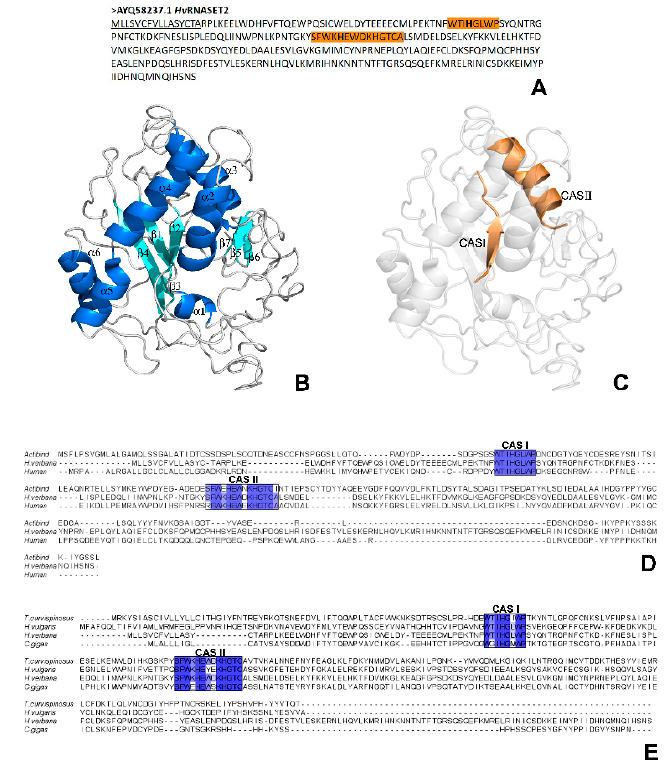
Figure 1. Hv RNASET2 bioinformatic characterization. ( A ) Hv RNASET2 (accession number: AYQ58237.1) amino acid sequence. In the N-terminal region, the underlined residues identify the signal peptide, and the two conserved active sites (CAS) are underscored in bright orange. ( B , C ) Secondary HvRNASET2 three-dimensional structure, predicted with I-TASSER. The β -strands and α -helix that composed the secondary structure are represented in cyan and blue ( B ). The CAS I and CAS II domains, reported in bright orange ( C ), are specifically located on the β 2-strand and α 3-helix, respectively. ( D , E ) Multiple sequence alignments. The H. verbana Hv RNASET2 amino acid sequence was aligned either with those of the well-studied A. niger ACTIBIND and human RNASET2 enzymes ( D ) or with T. curvispinus (Arthropoda), H. vulgaris (Cnidaria) and C. gigas (Mollusca) ( E ) invertebrate T2 RNases. Both the CAS I and CAS II domains are extremely well conserved, and di ff erent blue shades identify the distinct conservation of each specific amino acid.